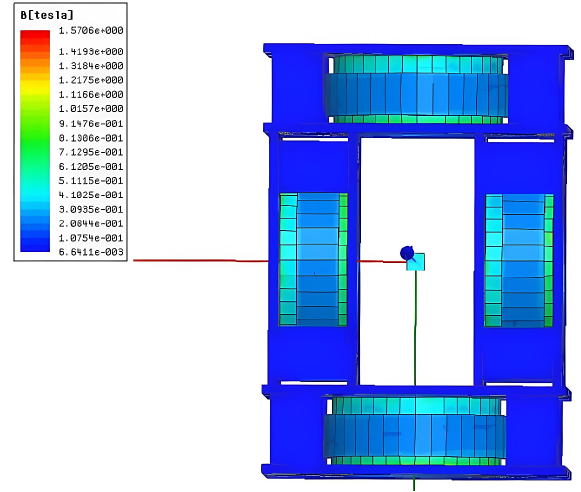
Figure 8. Cloud map of magnetic induction intensity at 70 mm.